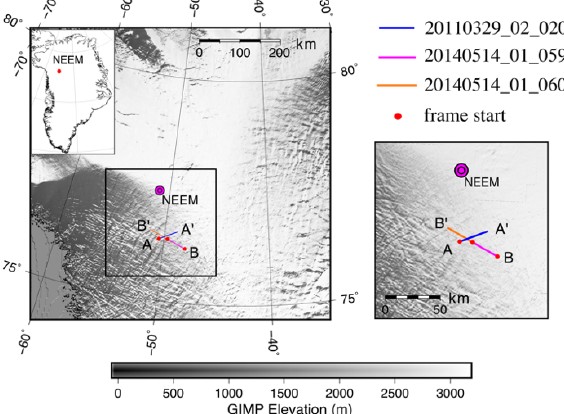
Figure 2. Study area and the flight track of the IceBridge MCoRDS data used in this study, the elevation data is from MEaSUREs Greenland Ice Mapping Project (GIMP).